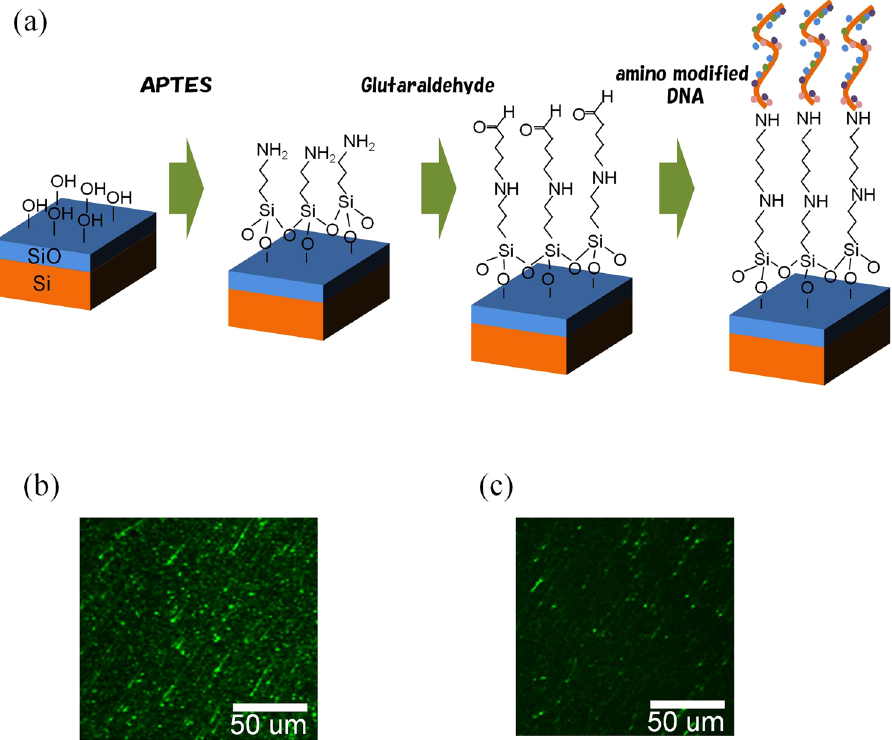
Figure 2. DNA immobilization on the probe. ( a ) Process for immobilizing the DNA on the surface of the probe. ( b ) Fluorescence imaging of the ssDNAs ([(dA) 50 -(dC) 50 ] m ) on the surface of the Si probe when the ssDNAs were bound with glutaraldehyde by peptide coupling. ( c ) Fluorescence image of the ssDNAs ([(dA) 50 -(dC) 50 ] m ) on the surface of the Si probe when the ssDNAs were not bound with glutaraldehyde by peptide